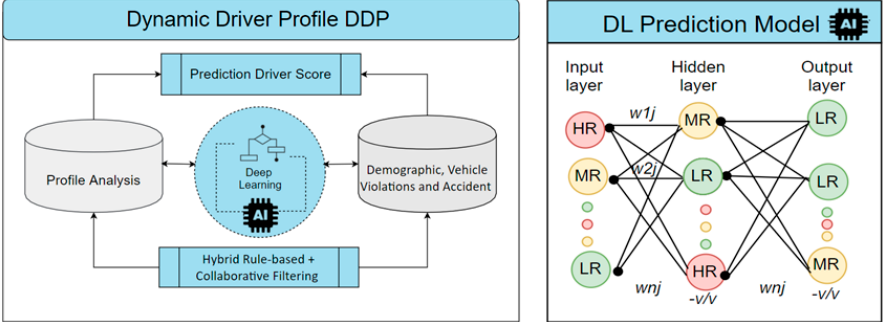
Figure 6. Deep learning prediction model.